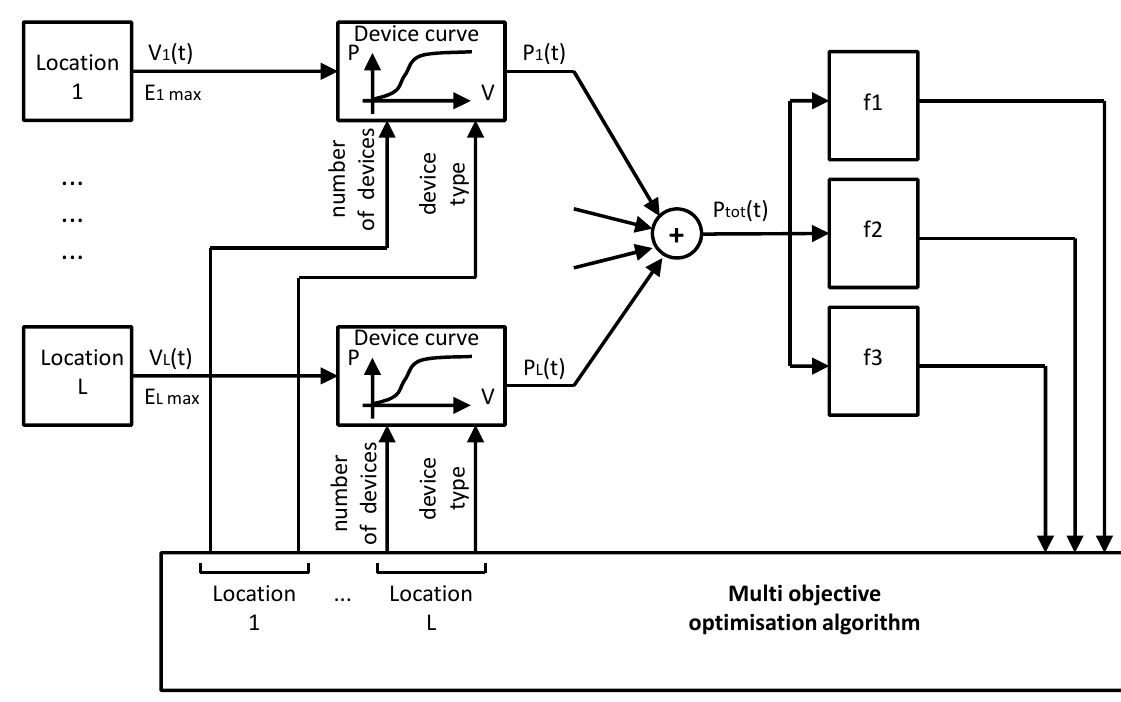
Figure 5. MOP block diagram. Device